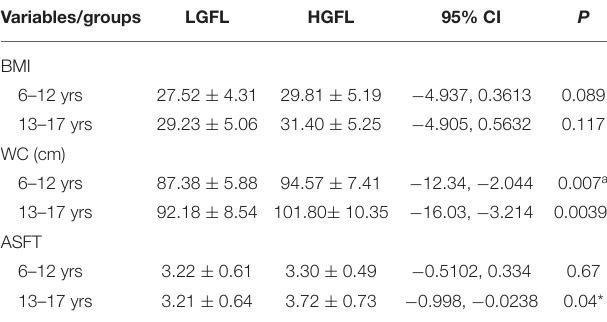
TABLE 3 | Values of body mass parameters between LGFL and HGFL in different age